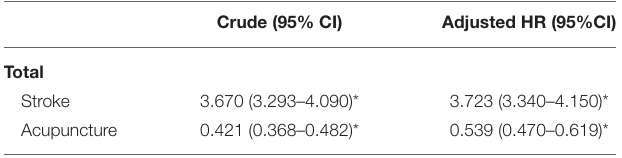
TABLE 4 | Crude and adjusted HRs of dementia among patients with stroke and those who have received